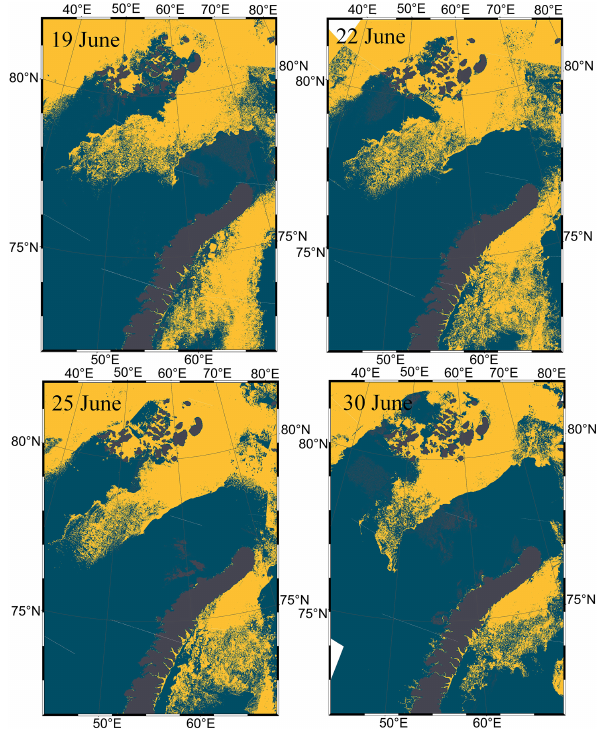
Figure 15. Example of the Arctic sea ice cover product in the Bar- ents Sea and Kara Sea of the Northeast Passage. Yellow represents sea ice, cyan represents open water, and gray represents